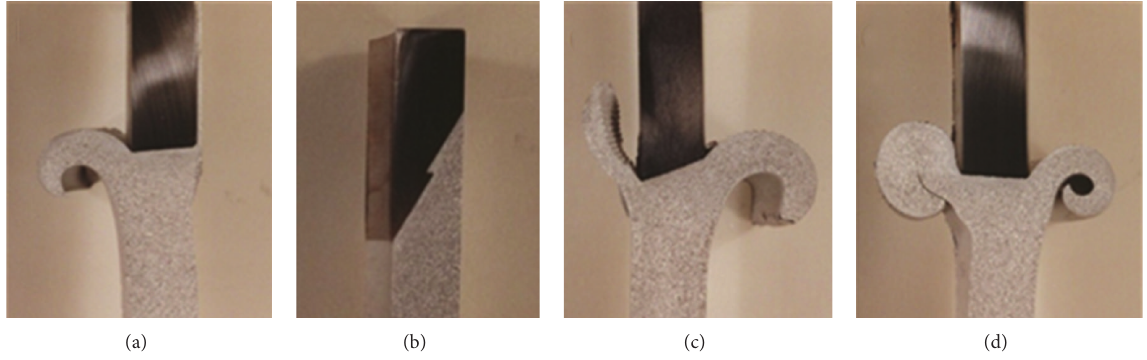
Figure 12: The view of a macrostructure of the pipe walls with a diameter of 50 mm, thickness of the wall of 10mm, from the friction welded AlMg3 aluminium alloy-X10CrNiTi189 austenitic steel joints, at various methods of forming the joints, with a mandrel, limiting the flash inside the pipe. The beven angle of the steel sample − 10 ∘ , rough turned surface (a), with 45 ∘ beven angle and with a lock (b), beven angle of the steel sample − 30 ∘ , rough turned surface (c), beven angle of the steel sample − 10 ∘ , but to the inside of the pipe, rough turned surface (d).